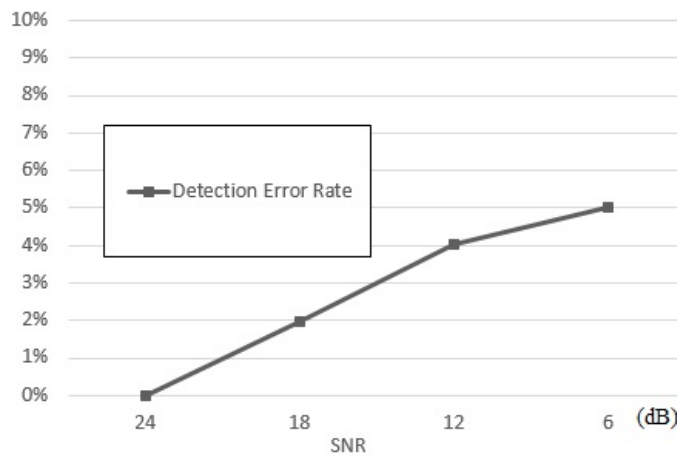
Figure 7. Detection error rate achieved as a function of different SNR values.